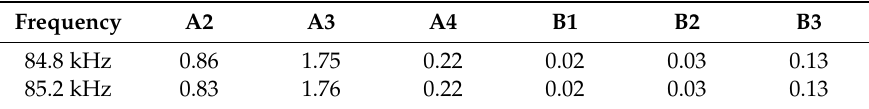
Figure 18. Magnetic field distribution of harmonic current: ( a ) harmonic current at 84.8 kHz; ( b ) harmonic current at 85.2 kHz. Table 7. Magnetic field strength at test points (A/m).